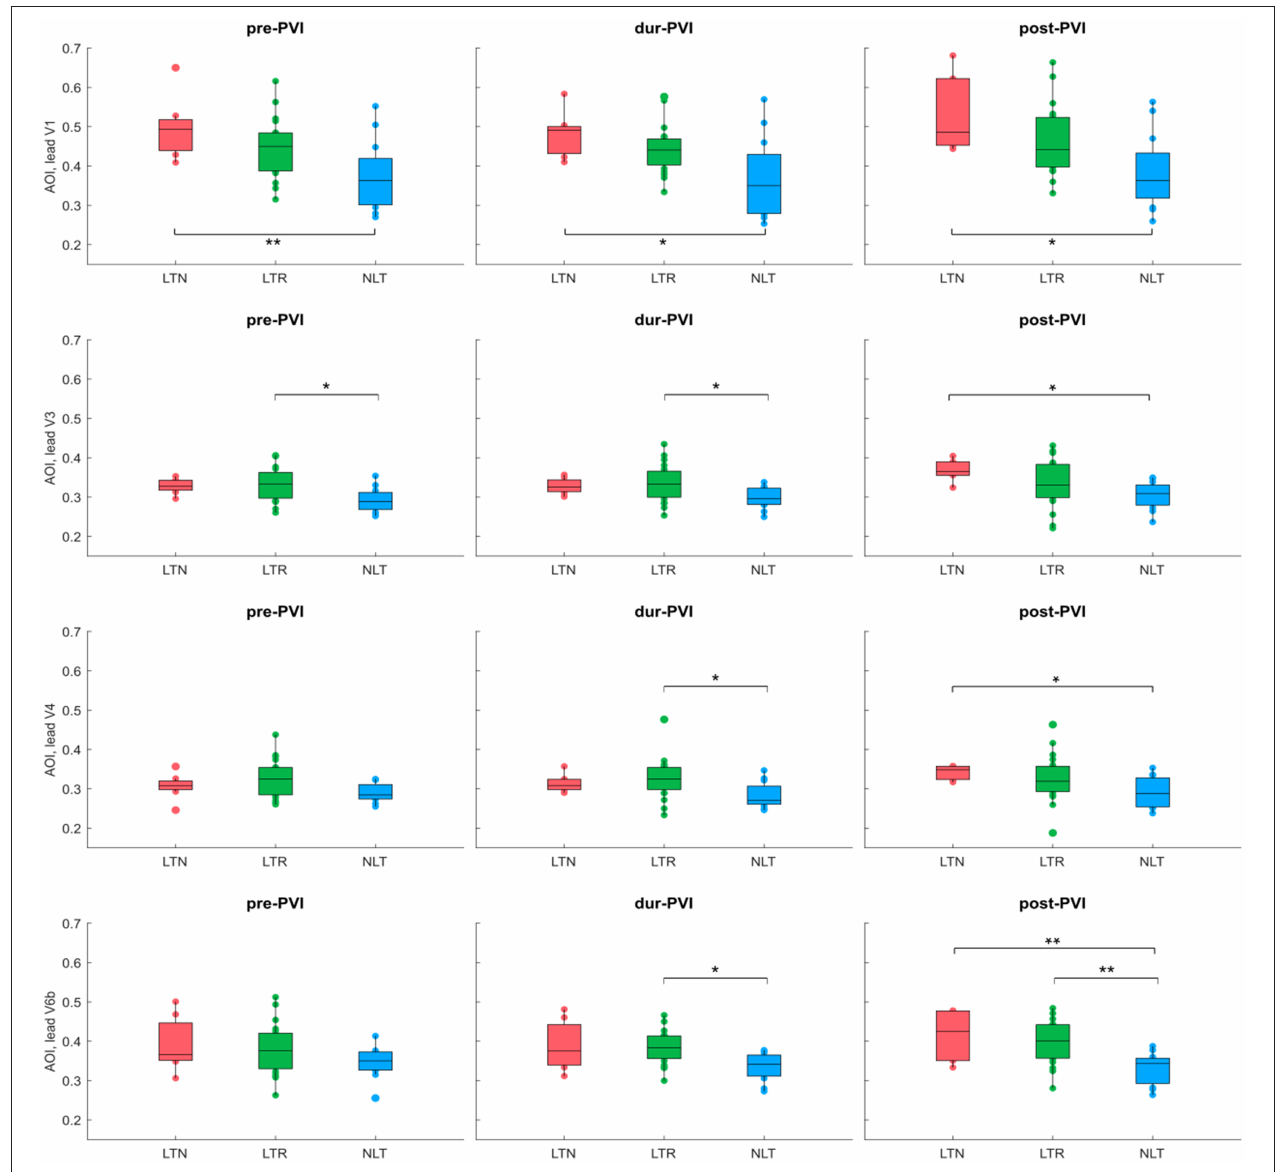
FIGURE 4 | AOI calculated on leads V 1 , V 3 , V 4 , and V 6 b at pre-PVI, dur-PVI, and post-PVI for all patient groups. Significant differences between groups at each ablation step are displayed; * p < 0.05 , ** p < 0.01 . Leads V 2 and V 5 not shown, as results were not significant on these